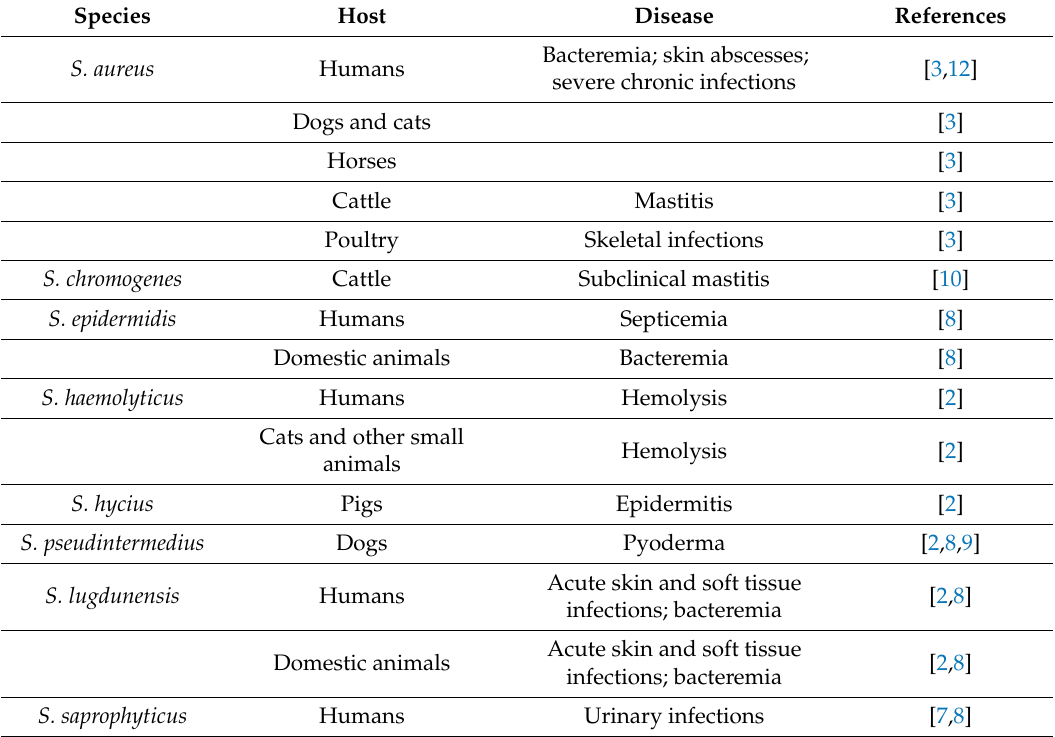
Table 1. List of pathogenic staphylococcal species and the diseases they may cause in humans and animals.